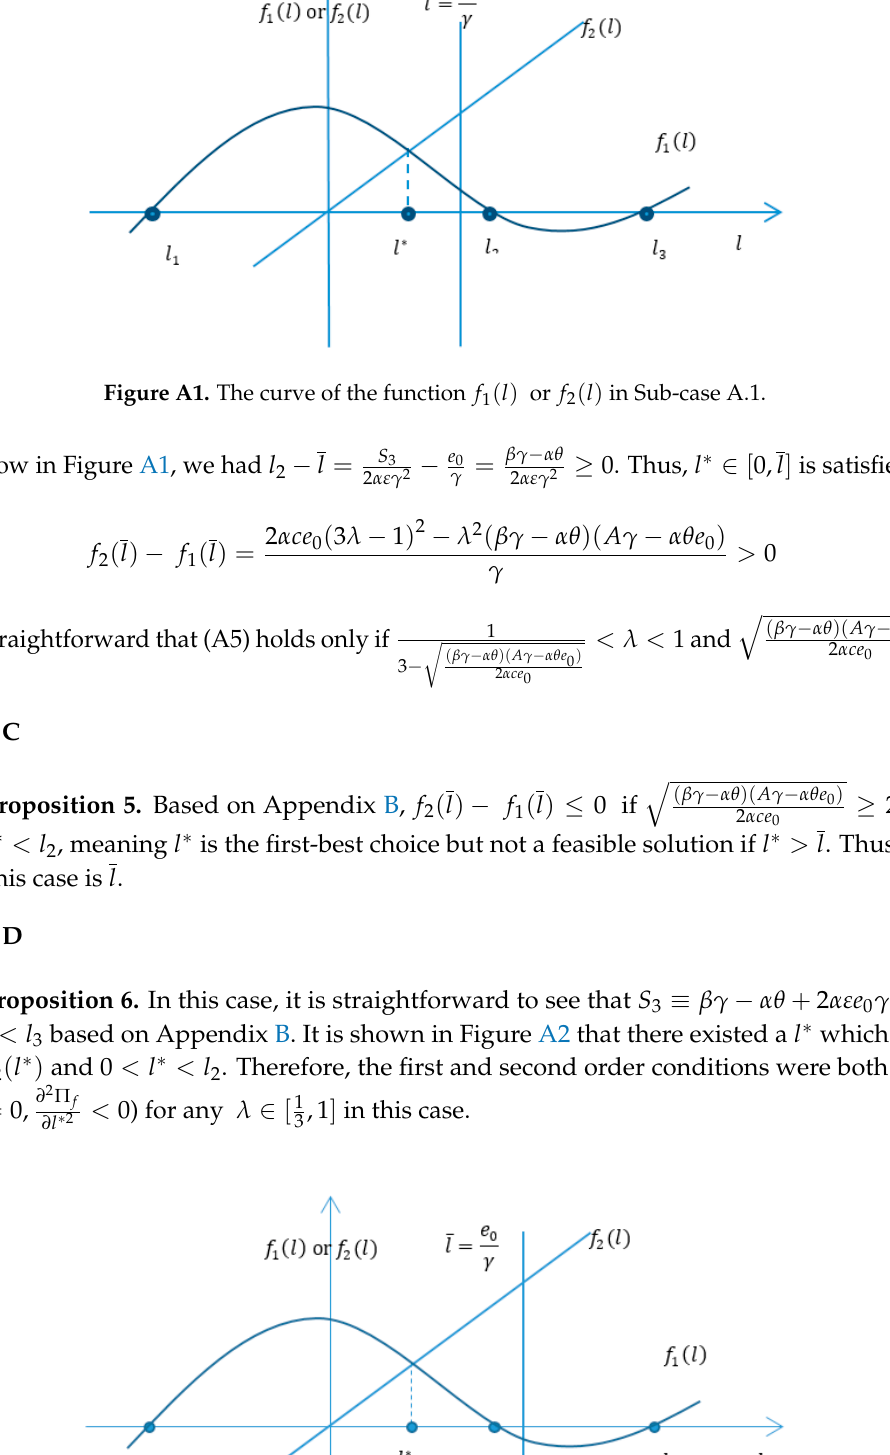
Figure A3. The curve of the function (cid:1858) (cid:2869) ((cid:1864)) or (cid:1858) (cid:2870) ((cid:1864)) in Sub-case B.2. References 1.